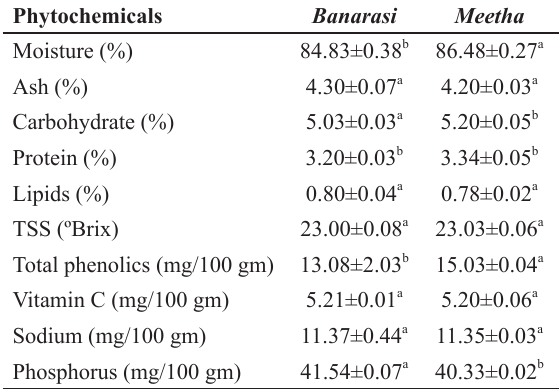
Phytochemical screening of betel